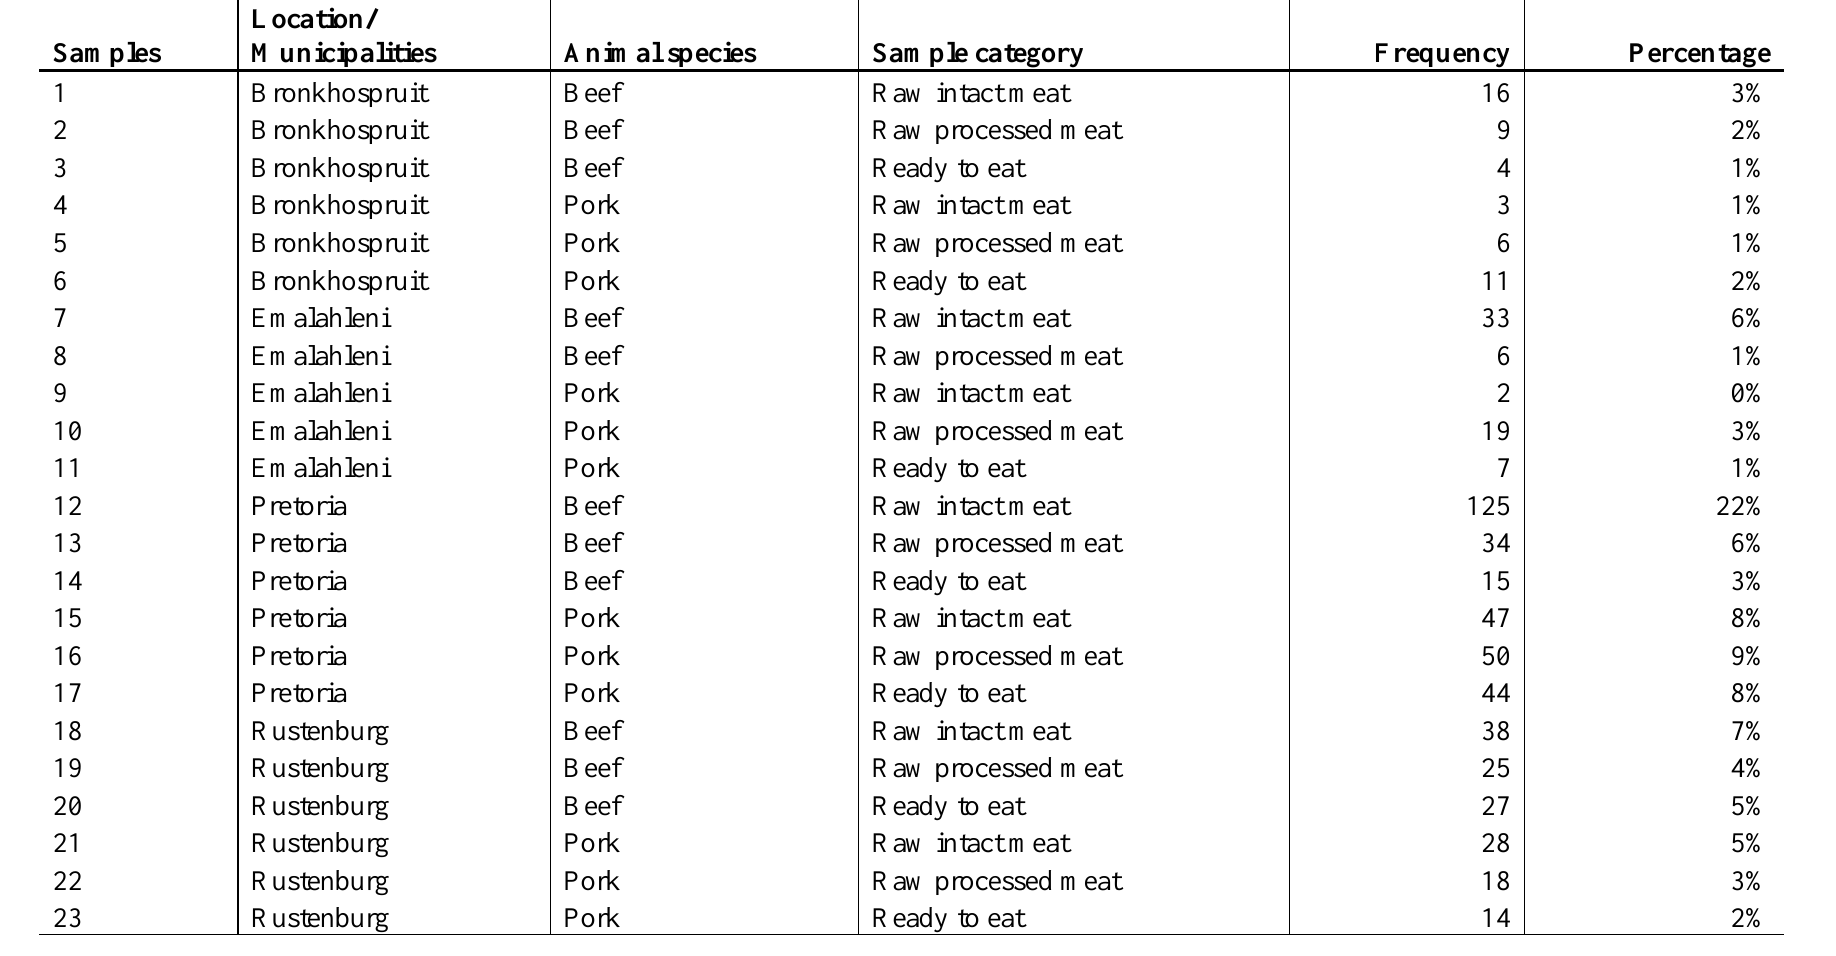
TABLE S2: Summary of data according to location, animal species and sample category.